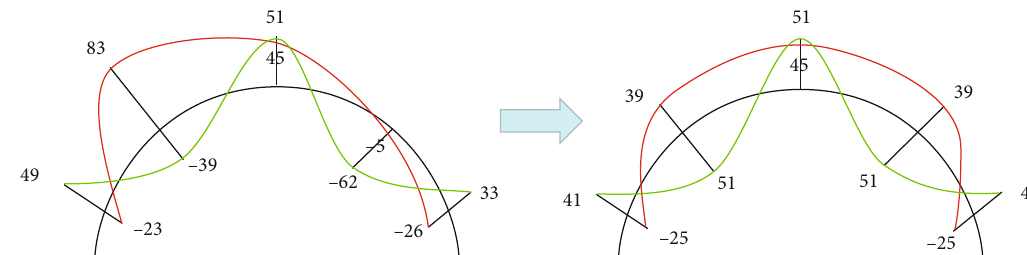
(c) Strain temporal curves of shotcrete in B test section Figure 7: Strain temporal curves of shotcrete.